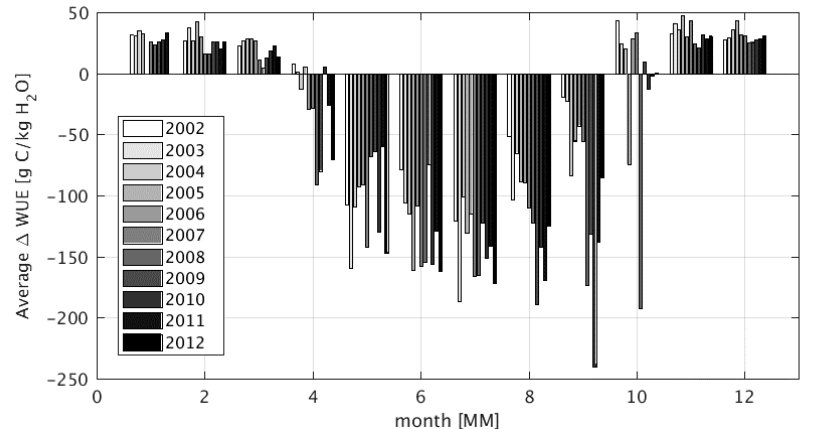
Figure 15. Bar plots of the monthly difference in water use efficiency (WUE) for all wetland pixels over the study period 2002 to 2012. Δ = WET − DRY. Each bar is normalized by the area of wetlands present. Note that area of wetlands disappear at lower elevations in dry years, and thus the more efficient water use later in the dry season reflects the small areas of wetlands at higher elevations, colder temperatures, and where subsurface flow is the source of moisture. The water-use overhead of productivity increases nonlinearly through the dry season.